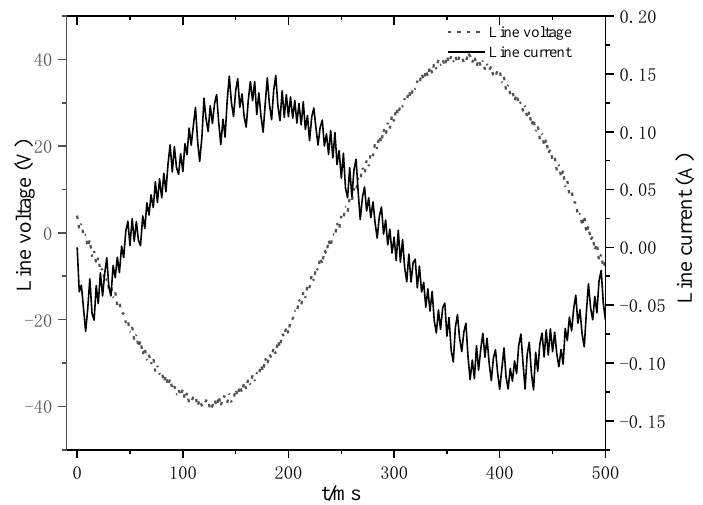
Figure 13. Measured line voltage and line current.